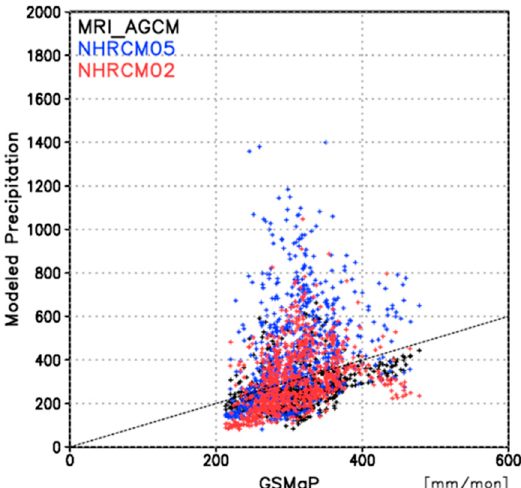
Figure 6. Scatter plot showing 20-year mean annual precipitation amount of GSMaP and NHRCM02. Black dots represent values (in mm/month) for entire domains including oversea areas, and blue dots represent values for land areas only.